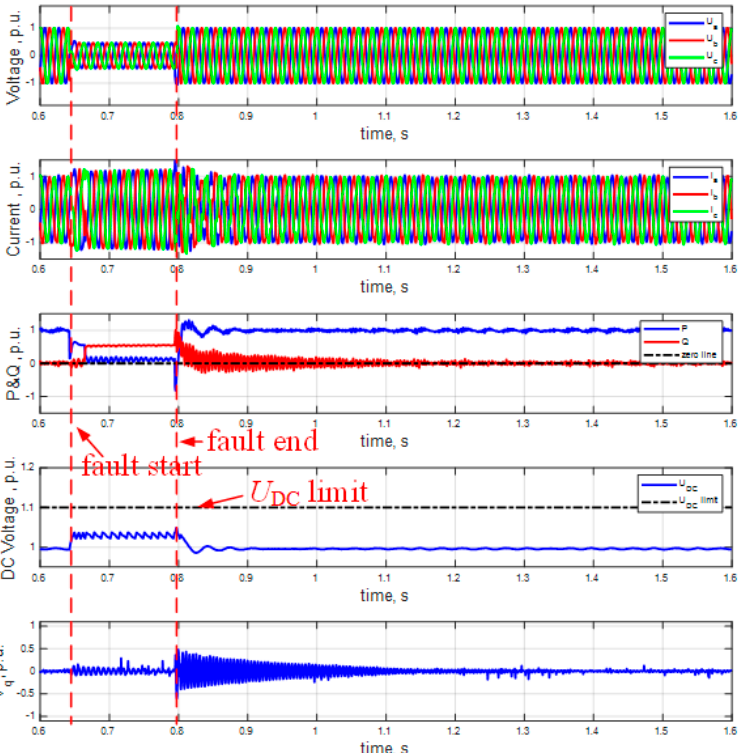
Figure 13. With reactive current injection, a reduction rate of * versed for a long time due to the slower reactive current exit rate (P curve below the black dashed line), eventually causing the DC voltage to exceed the upper limit (black dashed line).